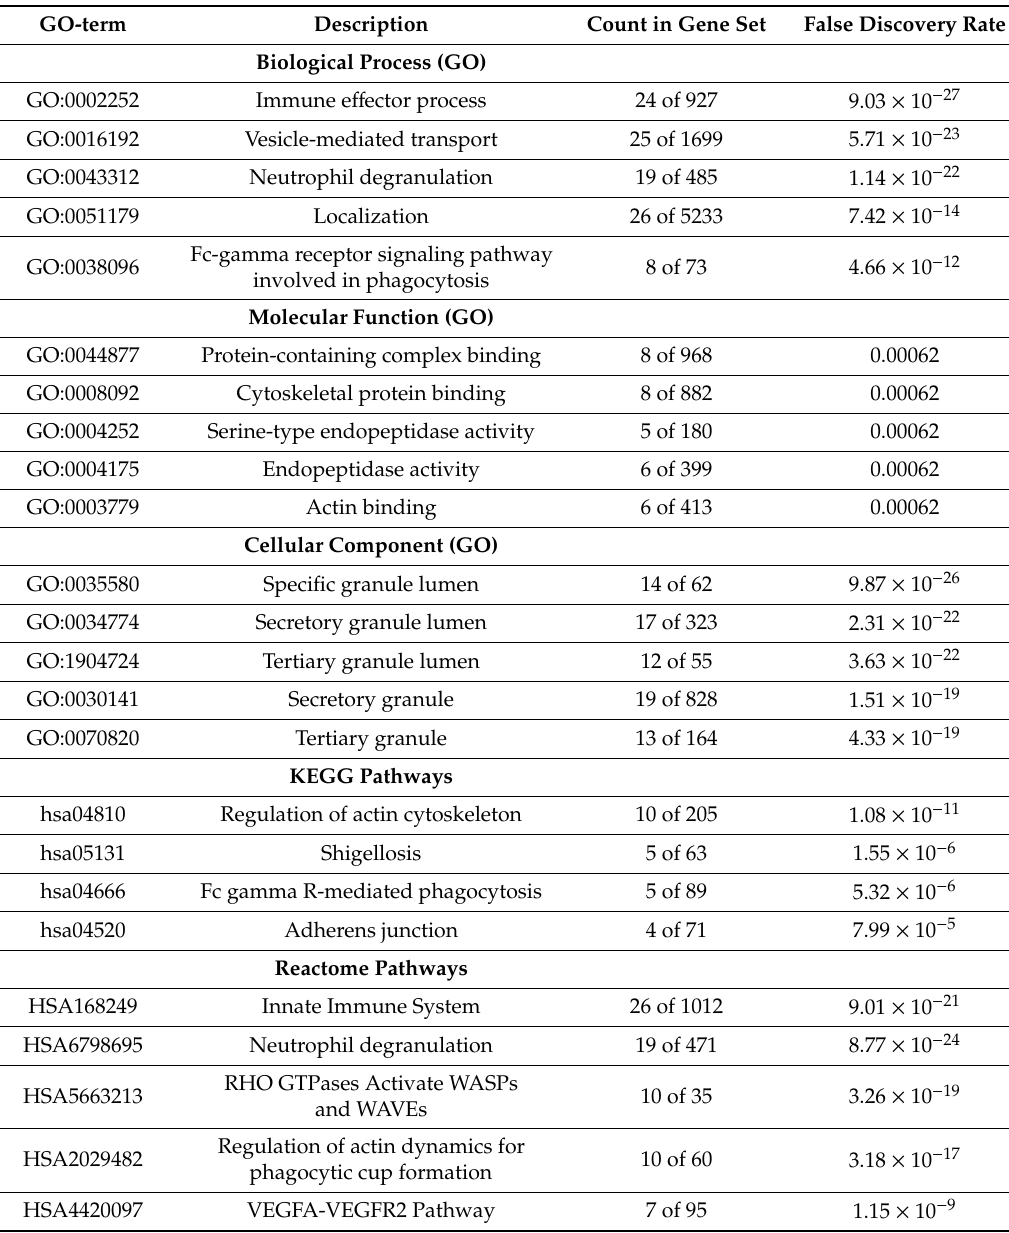
Table 9. STRING: Biological Process (GO), Molecular Function (GO), Cellular Component (GO) with KEGG, and Reactome Pathways for the CYFIP1